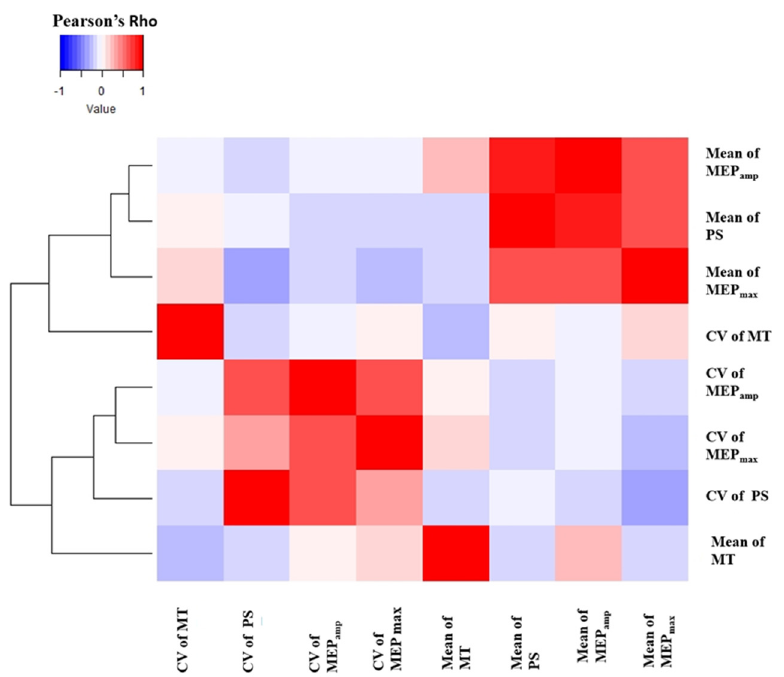
Figure 6. Correlation heatmap and dendrogram showing the relationships between the Coefficient of Variation (CV) and the means of all IOC parameters. PS—peak slope; MEP amp —motor evoked potential amplitude at 120% resting motor threshold; MT—motor threshold; MEP max —maximum MEP amplitude